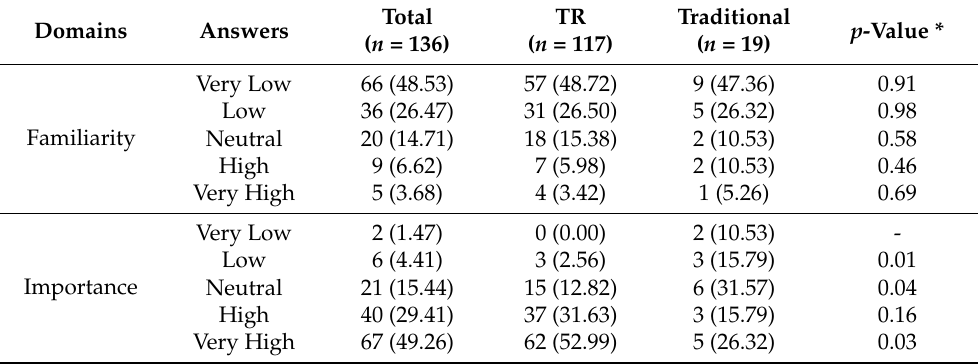
Table 2. Survey’s answers related to the TR, n